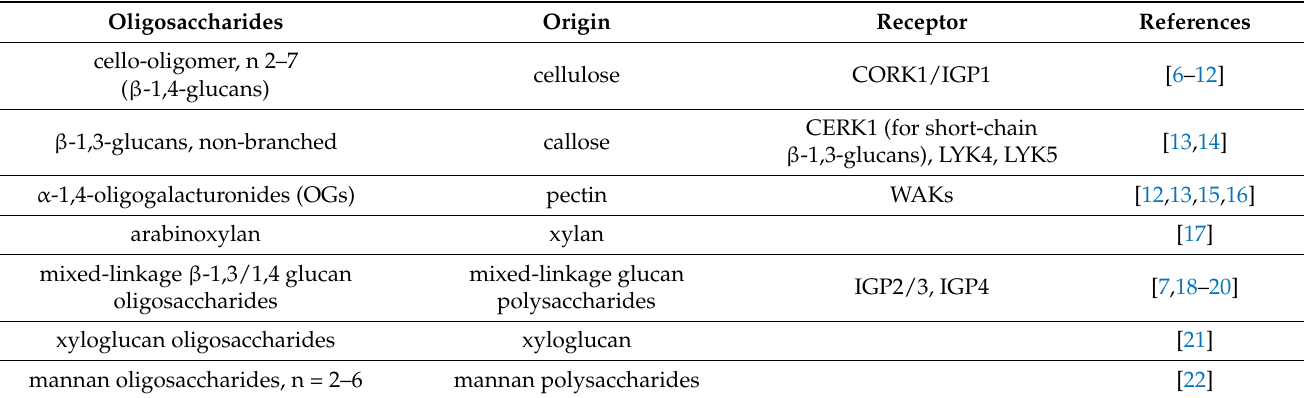
Table 1. Main plant cell wall-derived oligosaccharides from cell wall polysaccharides with elicitor function in immunity and wall